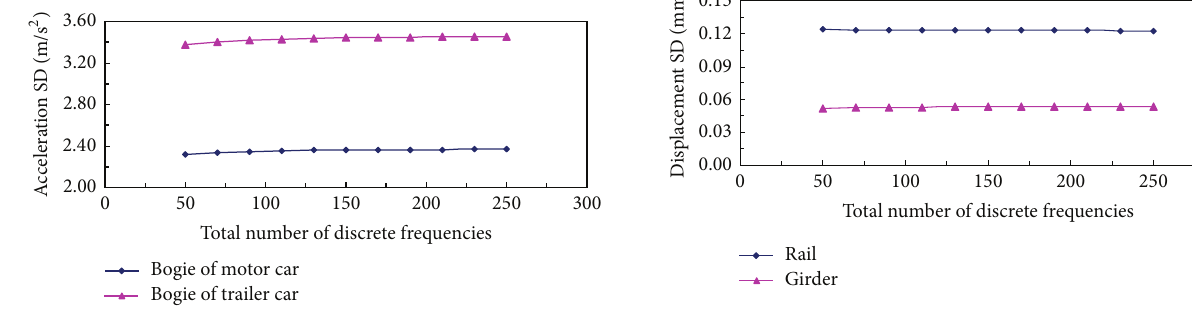
Figure 4: Maximum SD of vertical acceleration of rear bogie.